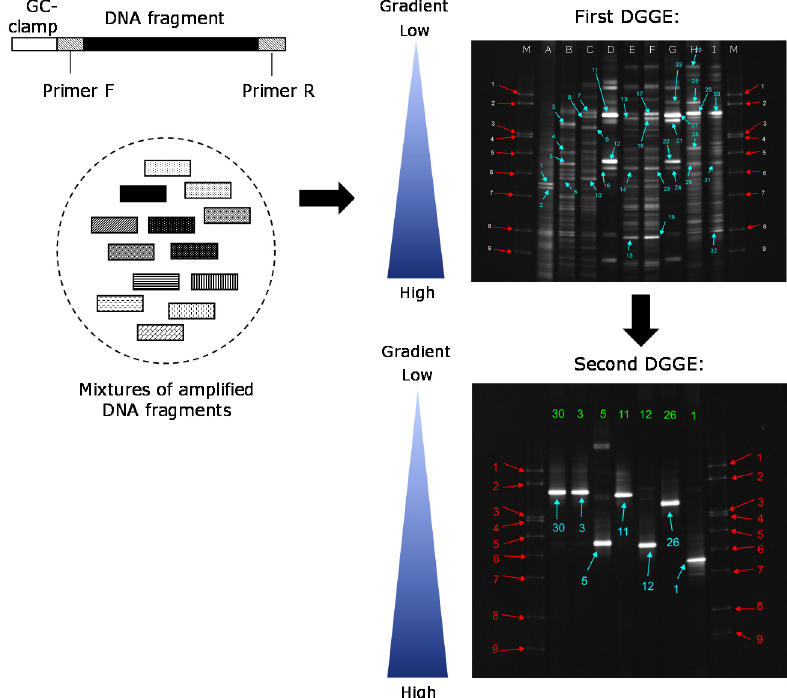
Figure 4. DGGE application in bacterial community study where the fingerprint of each sample is determined by the separation of the amplified partial 16S rDNA of equal length, whereby the different sequences are further resolved based on the gradient of denaturants from low to high concentration. This process might take several repetitions to get the best quality of the selected dominant sequences and overall can be quite